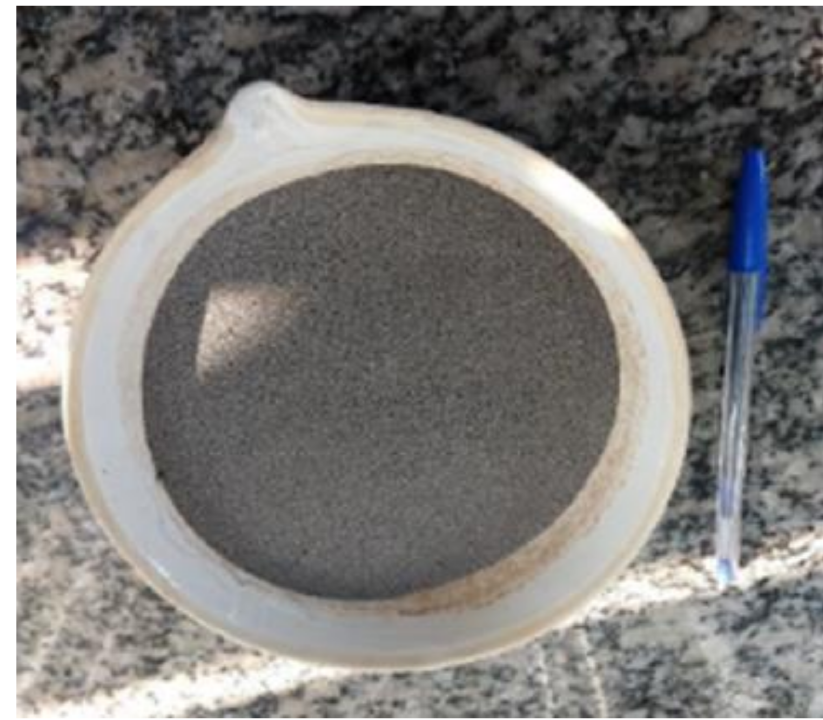
Figure 1. Waste foundry exhaust sand sample. Source: